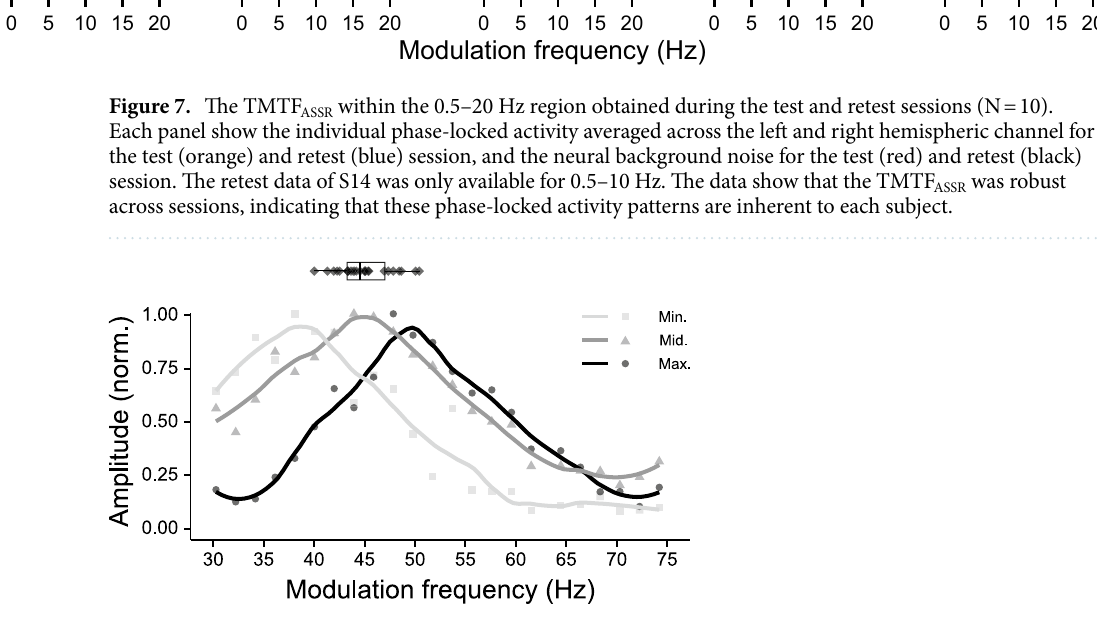
Figure 8. The individual f peaks within the 30–60 Hz range are represented in black diamonds and its distribution as a boxplot. The three curves show the responsiveness of three different subjects that are representative for the intersubject variability of the response patterns from which the peak frequencies are derived (i.e. min, mid, and max are from the subject with the lowest, around the median, and the max peak frequency within the group, respectively). All curves are normalized to the maximum value of each subject and are smoothed for illustrative